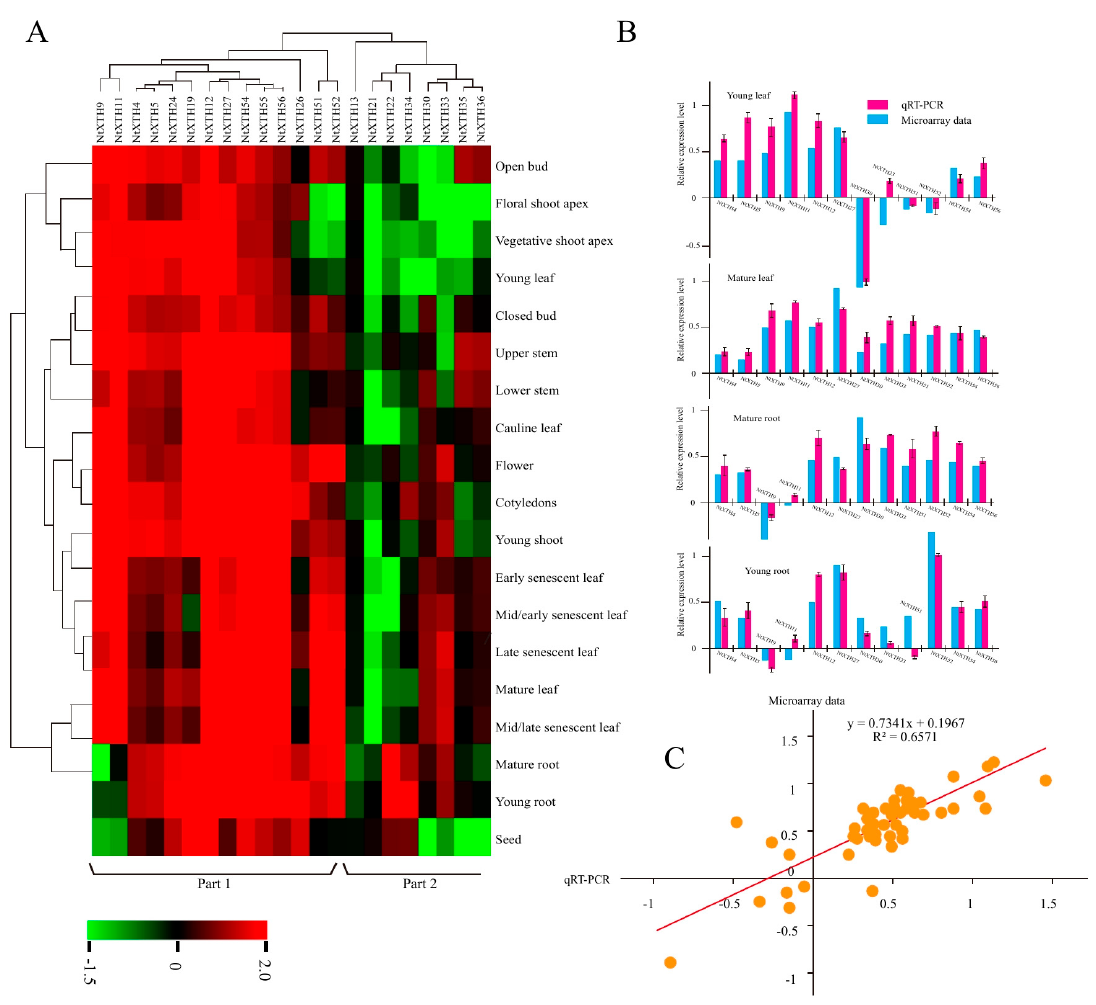
Figure 7. Microarray and RT-PCR analysis of NtXTHs in different tissues. ( A ) Hierarchical cluster analysis of NtXTH gene expression in different tissues. The expression data were collected through the public RNA-seq database TobEA. The mean expression value of each gene was log 2 transformed to create the hierarchical map. Each column represents the transcriptional units of XTH genes. The rows represent the different tobacco tissues. Green represents the lowest expression and red represents the highest expression. ( B ) Comparison of changes in the abundance and expression levels of selected NtXTH genes. ( C ) Coefficient analysis between gene expression ratios obtained from TobEA and qRT-PCR data.